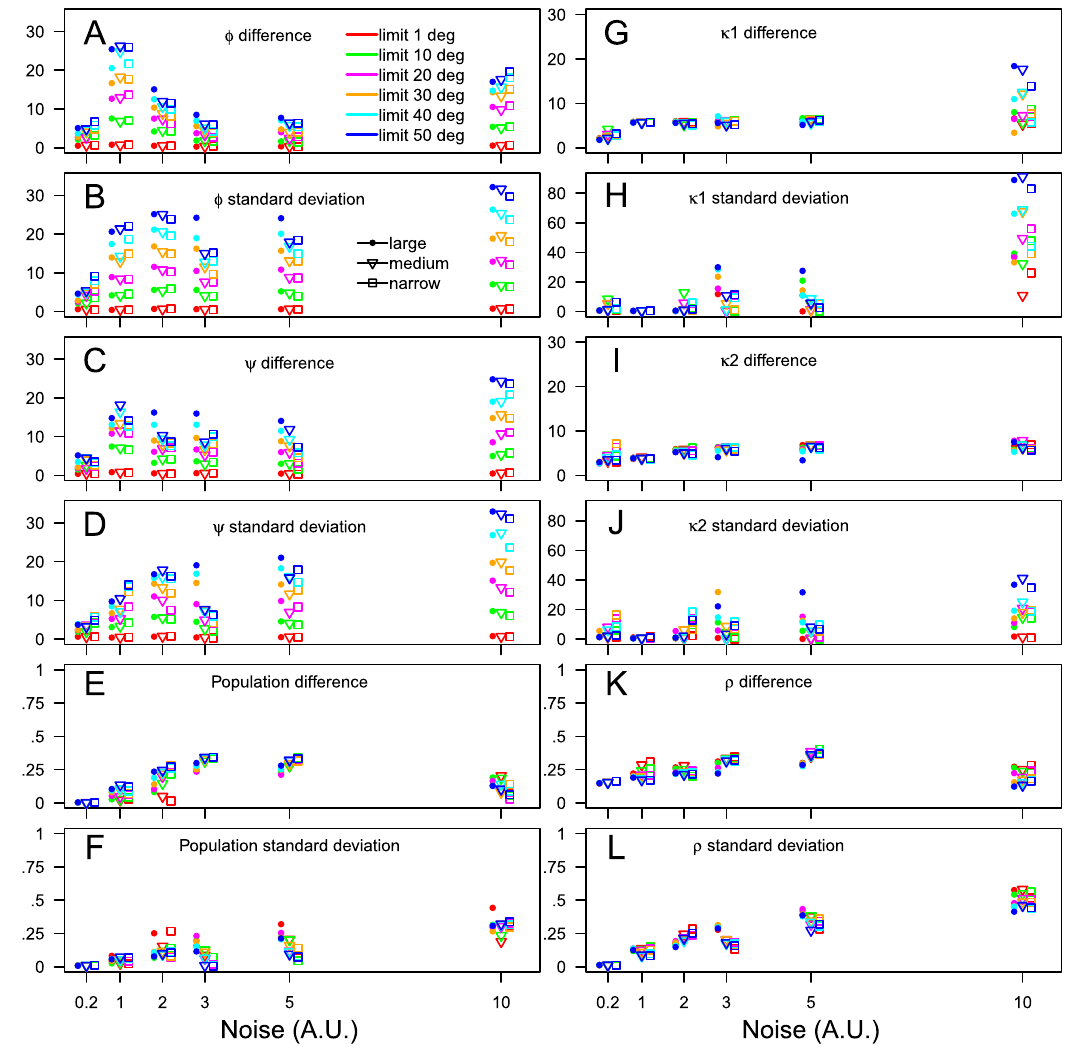
Figure 3. Efficiency of RamaMix for determining the φ 0 , ψ 0 positions ( A – D : Eq. 7), the von Mises shape parameters κ 1, κ 2 and ρ ( G – L : Eq. 8), and the populations γ q ( E – F : Eq. 2) using synthetic data and various noise levels described in Fig. S7. The results obtained for large, medium and narrow scattered synthetic Ramachandran maps are drawn as bullets, triangles and